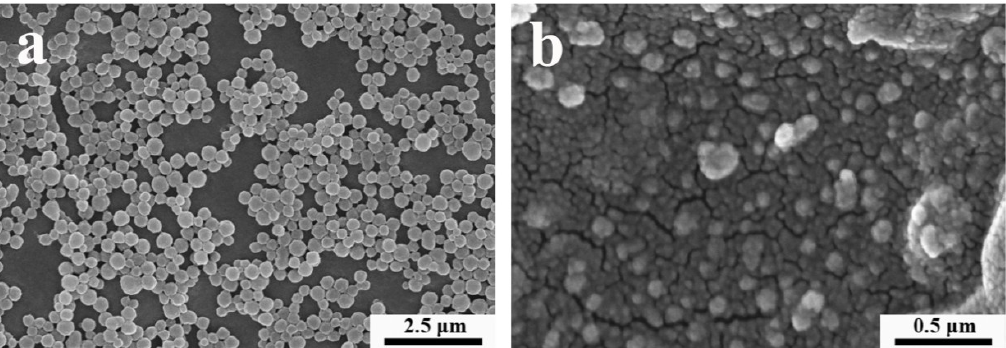
Figure 1. Field-emission scanning electron microscopy (FE-SEM) images of chitosan-cinnamon essential oil microcapsules ( a ) and chitosan particles without entrapped cinnamon oil ( b ) at 10,000 × ( a ) and 100,000 × ( b ) magnifications, respectively.